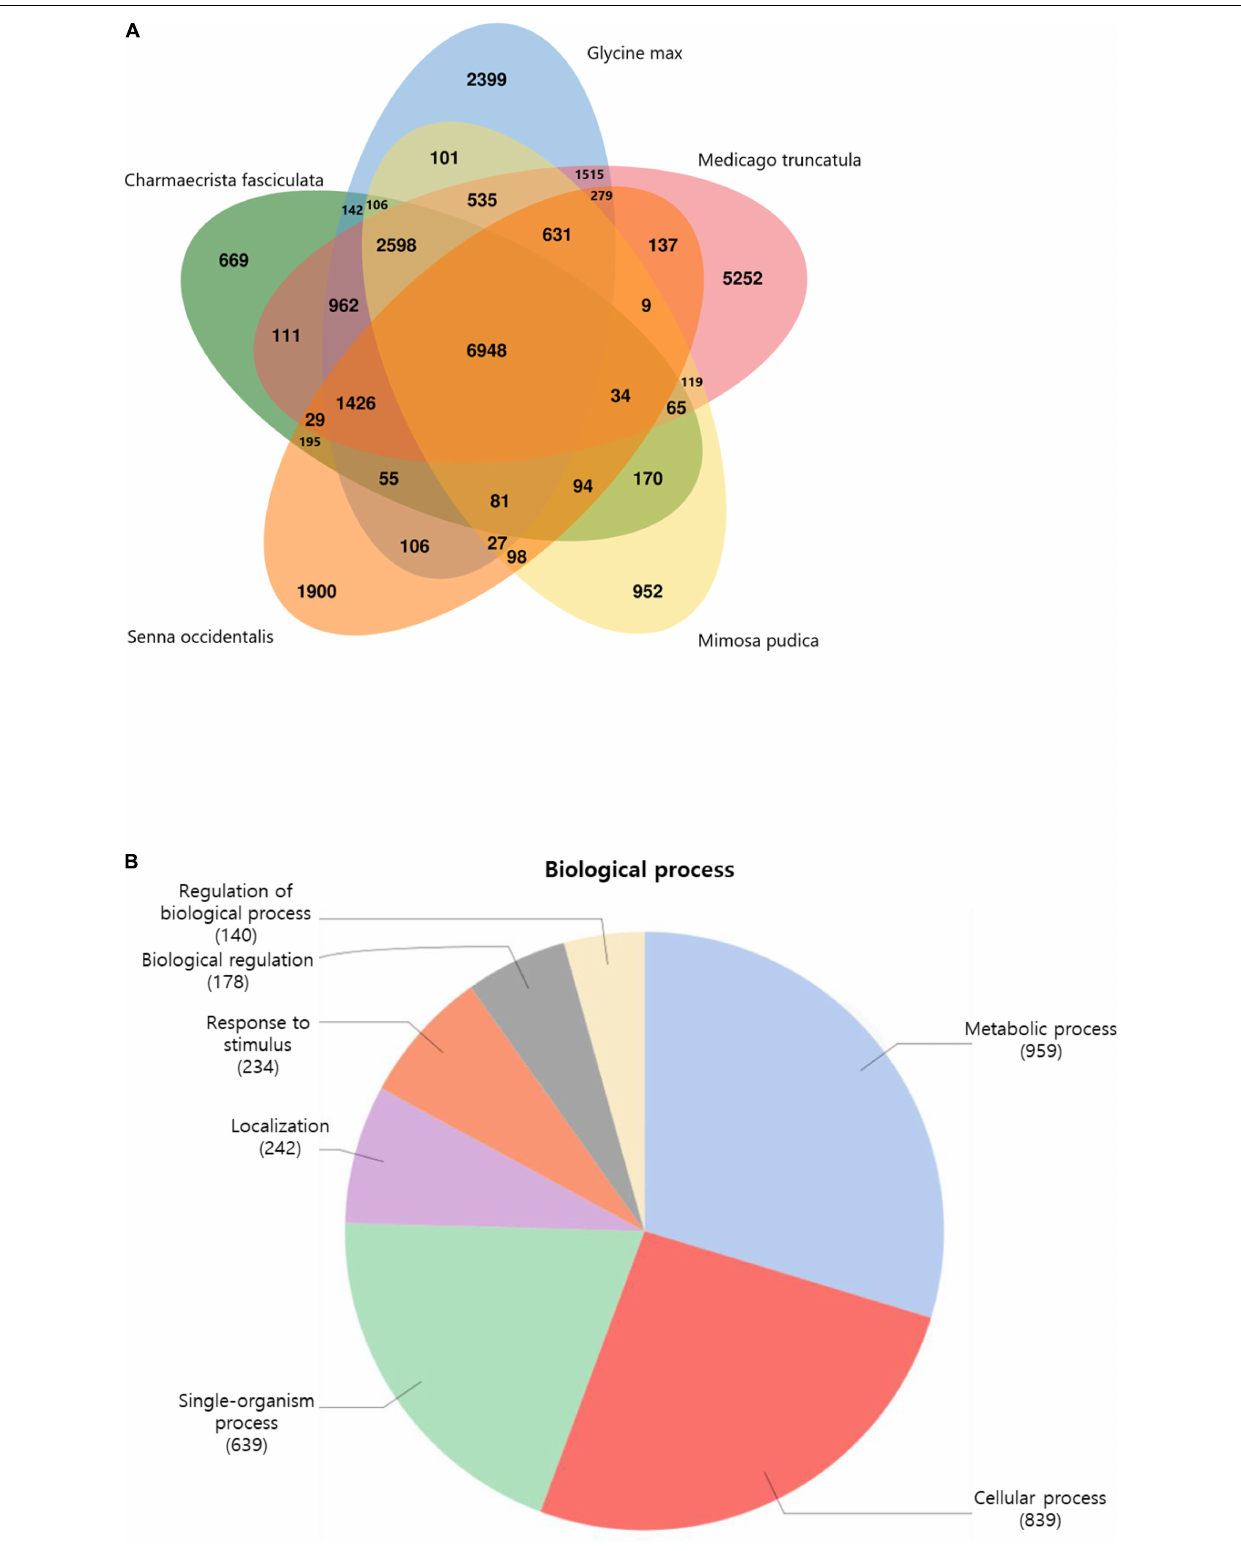
FIGURE 1 | Histogram of gene family distribution between legume plants. (A) The gene family distribution between Senna occidentalis (Iso-Seq dataset) and other plants. (B) Gene Ontology analysis of the novel gene families of S. occidentalis associated with the biological process categories.